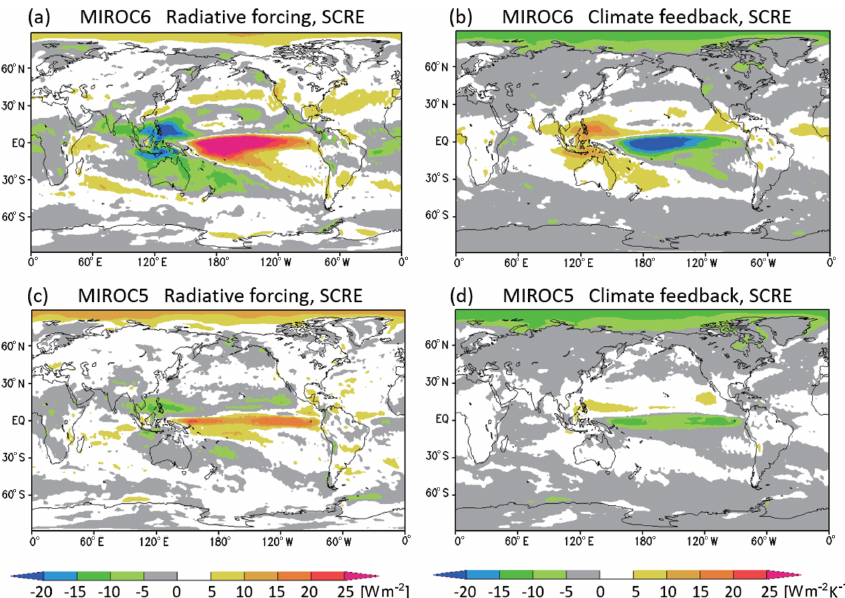
Figure 31. Shortwave cloud component of (a, c) 2 × CO 2 radiative forcing and (b, d) climate feedback in MIROC6 (a, b) and MIROC5 (c, d)